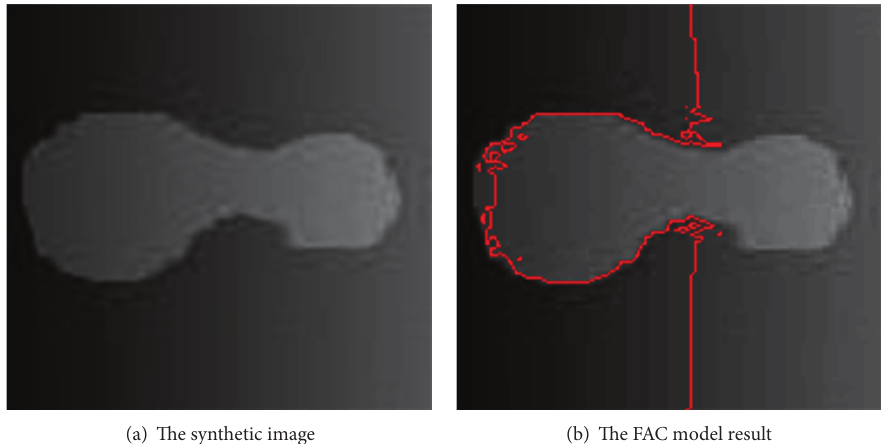
Figure 1: The segmentation result of the FAC model on a synthetic image.